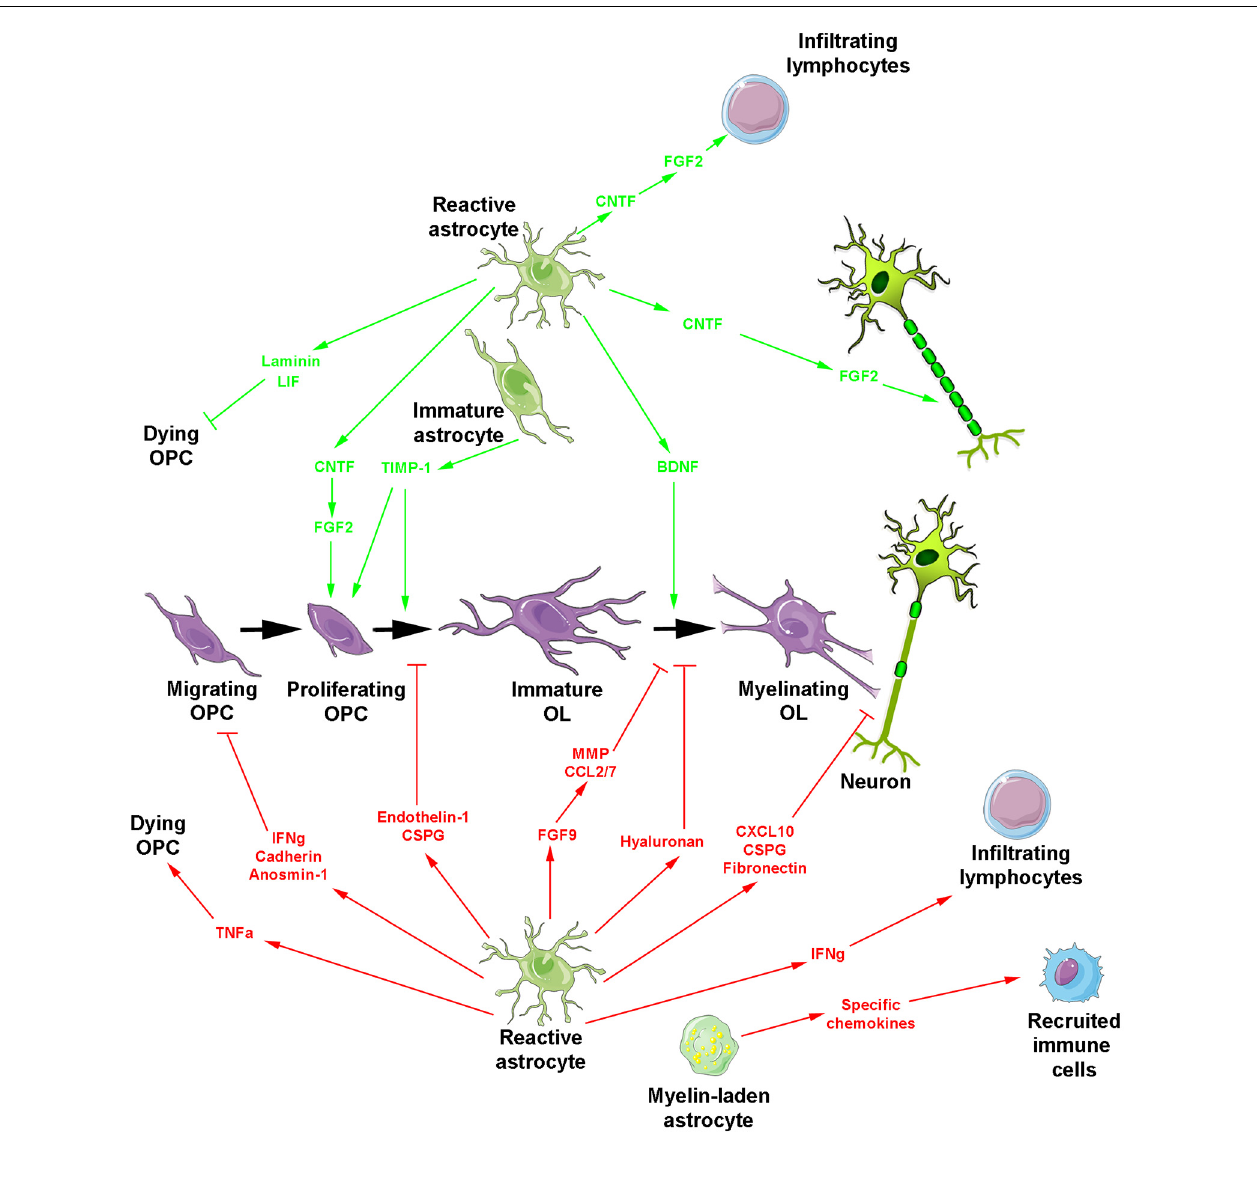
FIGURE 2 | Reactive astrocyte-derived secretion products during myelin repair. The oligodendroglial lineage is shown in purple. Reactive astrocytes generate molecules promoting (top, green arrows) or blocking (bottom, red arrows and blocking symbols) myelin regeneration. Besides reactive astrocytes, two additional forms of astrocytes are indicated including myelin-laden astrocytes endowed with a deleterious effect under inflammatory conditions and transplanted immature astrocytes which promote OPC proliferation/differentiation and additionally prevent glial scar